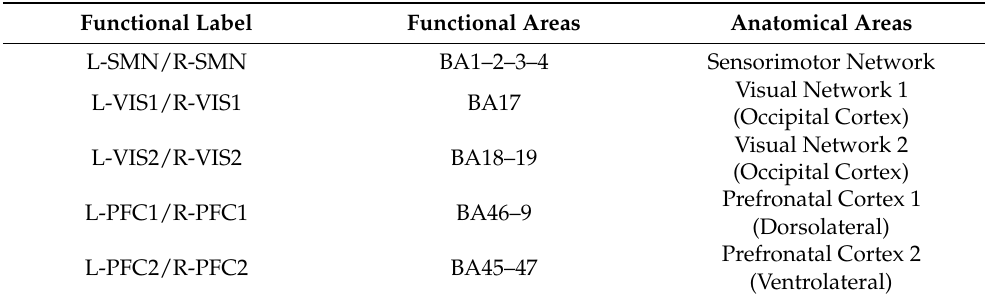
Table 7. Summary of employed left (L) vs. right (R) ROIs and their correspondence in functional and anatomical areas. Functional